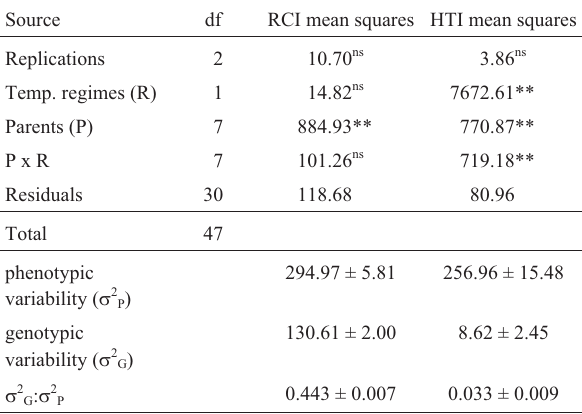
Table 1 - Mean squares from the analyses of variance for phenotypic differences among parental upland cotton cultivars for cellular membrane thermostability (CMT) as measured by relative cell injury (RCI) across temperature regimes and heat tolerance index (HTI) across years.